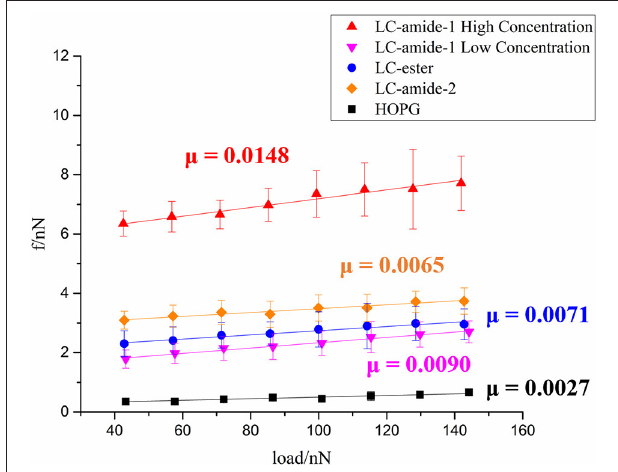
FIGURE 3 | Friction force as a function of applied load of LC-amide-1 at high/low concentration, LC-amide-2, LC-ester, and HOPG.